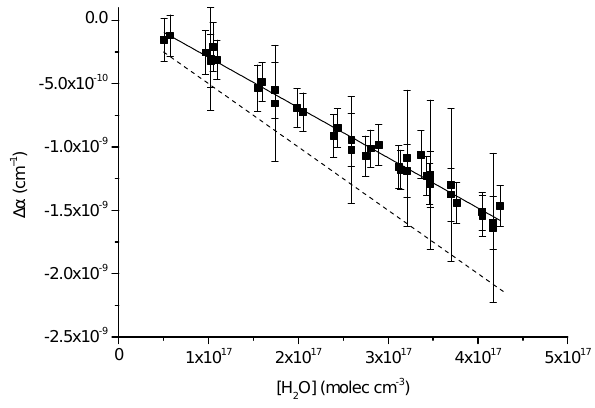
Figure 5. Determination of the scattering cross section of H 2 O at 405nm. (cid:49)α is the change in measured extinction when H 2 O is added to dry air ( (cid:49)α = α (RH = 0) – α (RH>0)). The dashed line is the calculated value of (cid:49)α when using the difference in scattering cross sections in dry and humid air reported by Fuchs et al.